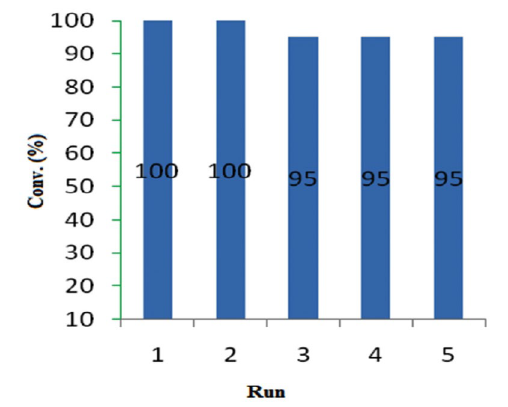
O @HAp-FeII and γ-Fe 2 3